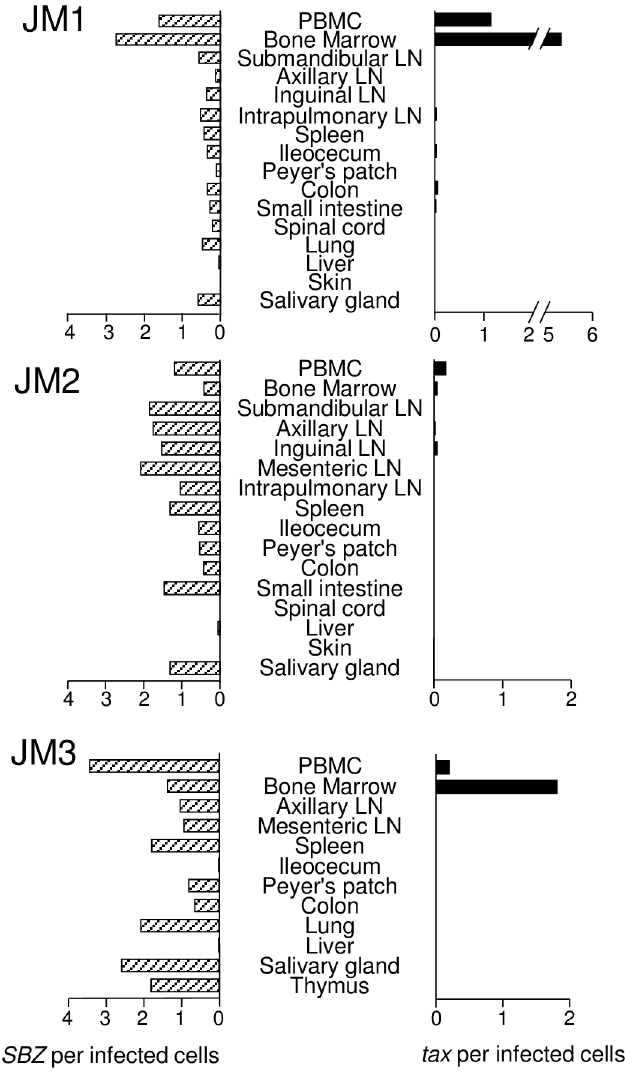
Fig 1. Tax and SBZ expression in STLV-1 naturally infected monkeys. SBZ and tax expressionlevel in varioustissues and organs of STLV-1 naturallyinfected Japanesemacaques(JM1-3) was measuredby quantitative PCR. The relative expressionlevel per proviruswas